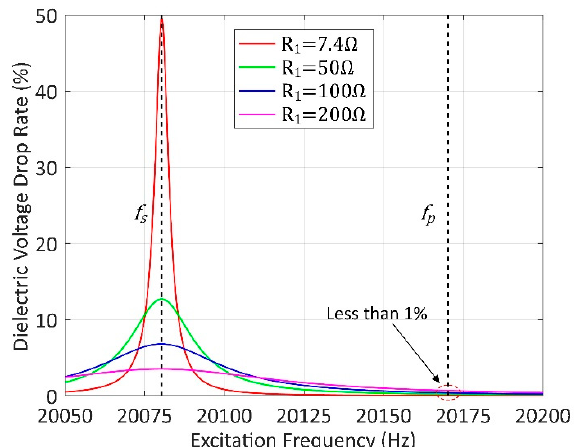
Figure 3. Dielectric voltage drop rate under different frequencies and loads.